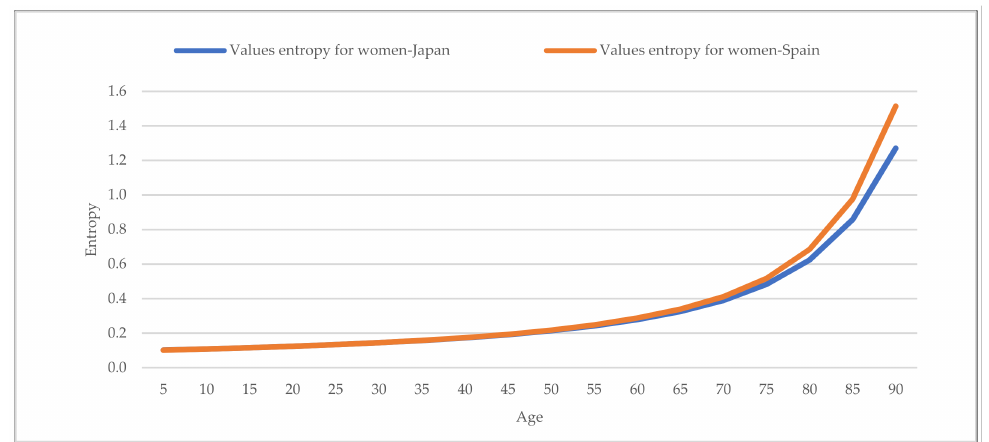
Figure 5. Japan vs. Spain entropy measurements for the female population according to the age of the individual. Source: authors.